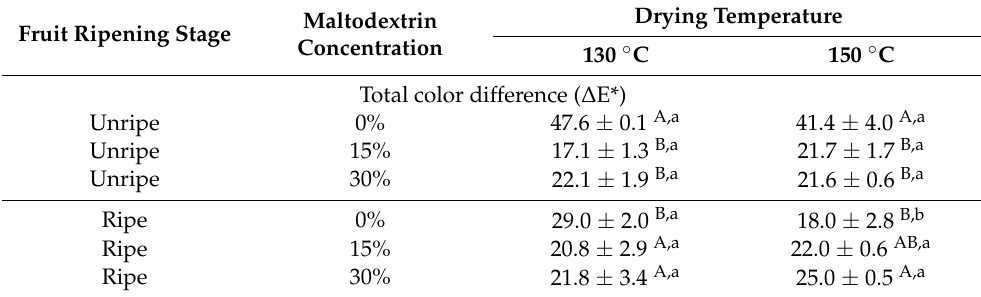
Table 4. Color stability of spray dried powders with papaya seed extracts and maltodextrin as a carrier. Fruit Ripening Stage